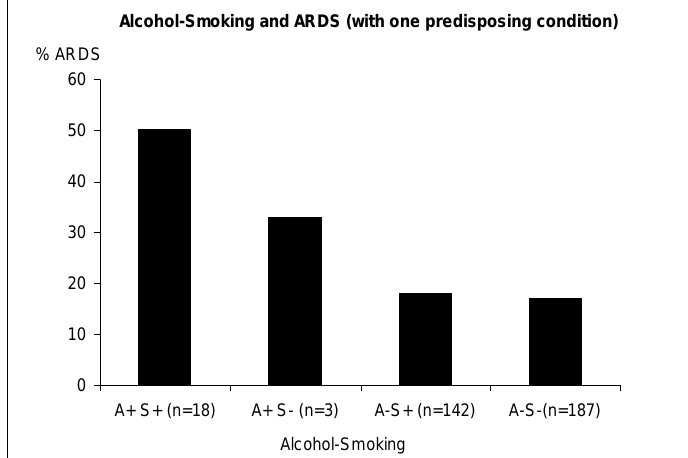
Figure 3. Frequency of ARDS according to alcohol and smoking history A-alcohol, S-smoking (p < 0.005 Chi Square test; no significant differences were found between A+S- and other